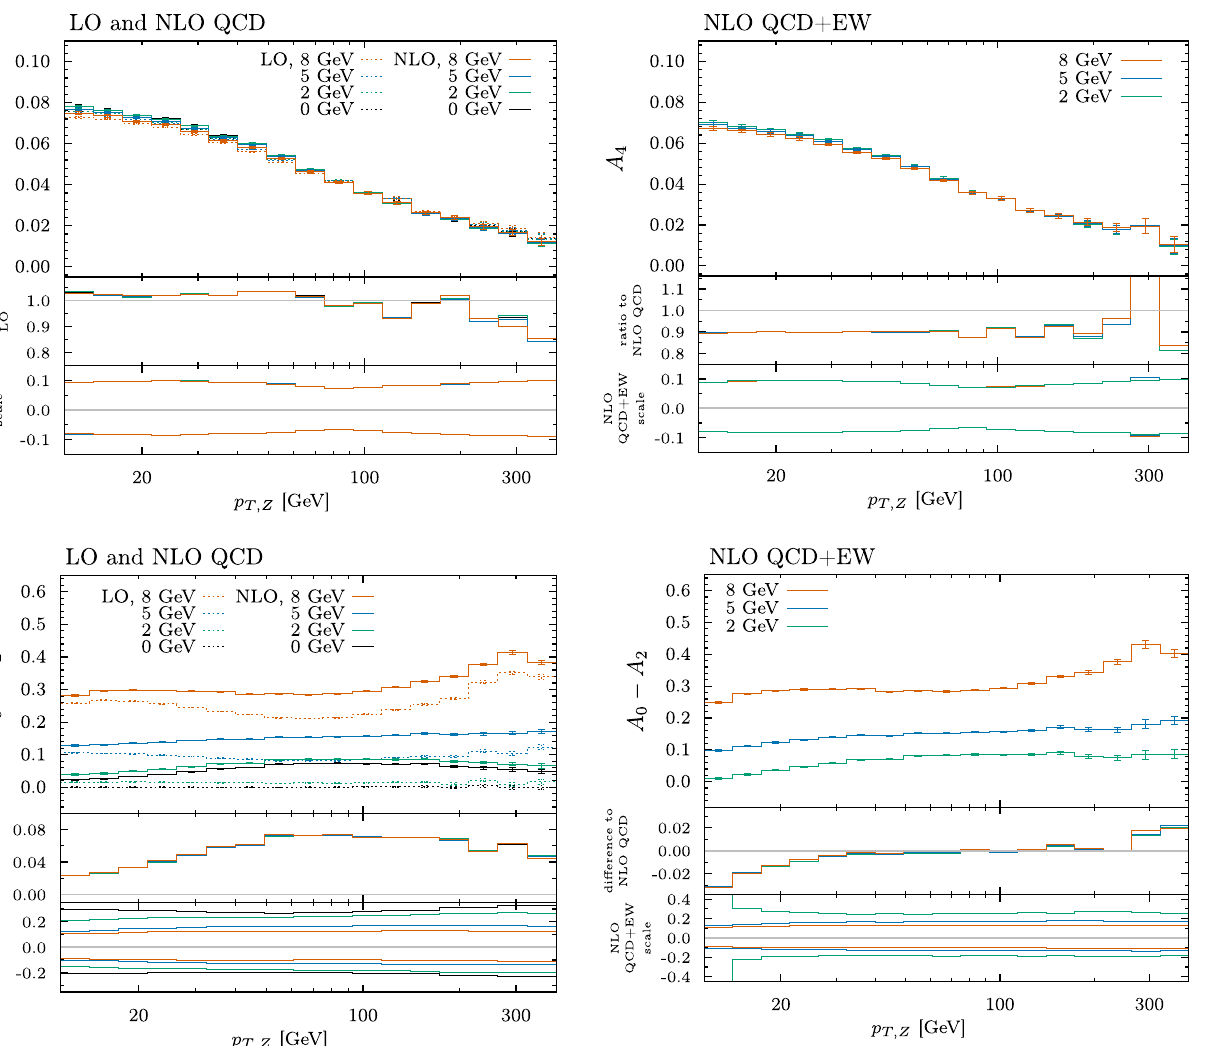
Fig. 4 The angular coefficient A 4 (top) and the Lam–Tung difference A 0 − A 2 (bottom),theLOandNLOQCD(left)andtheNLOQCD+EW contribution (right) with corresponding ratios and scale uncertainties.